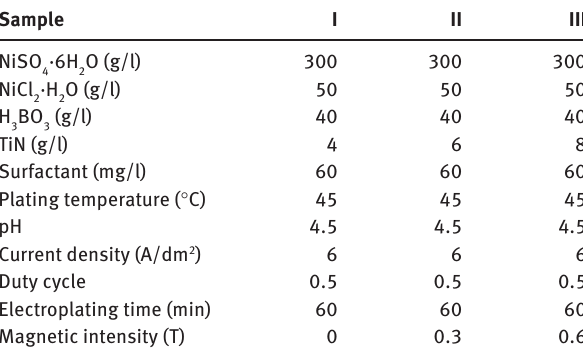
Table 1: Electrolyte composition and plating parameters for Ni-TiN composite coating